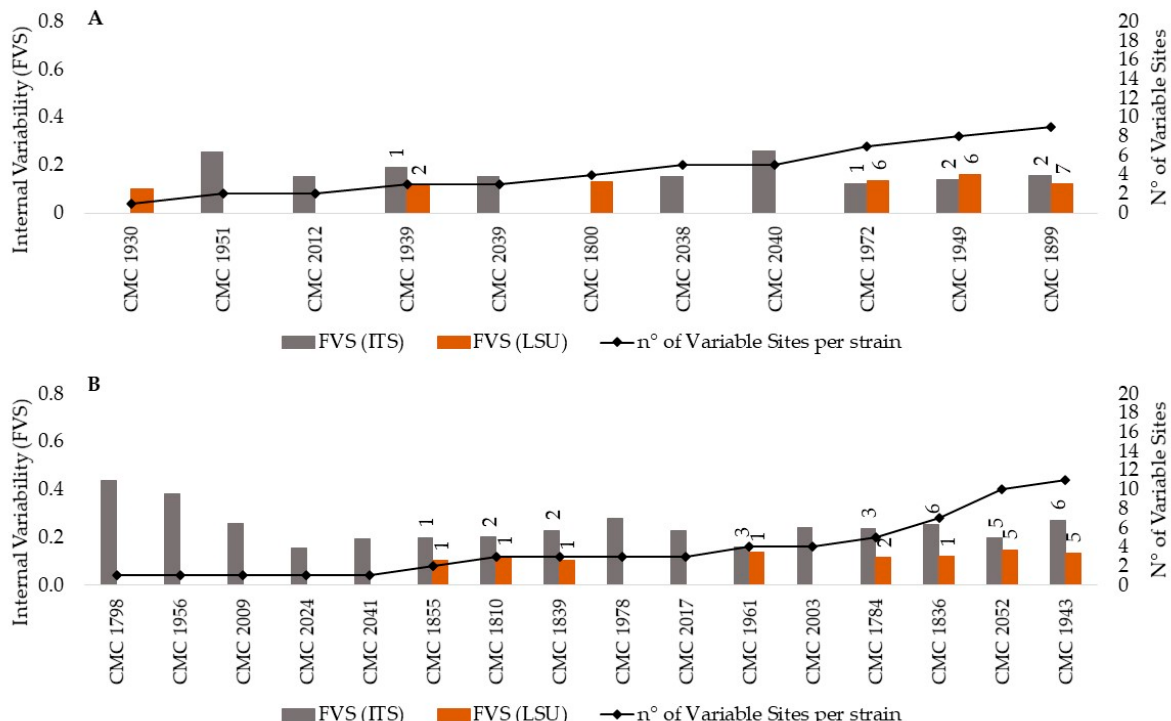
Figure 3. Heterogeneity of the rDNA within C. parapsilosis and C. tropicalis strains. Legend. Heterogeneity of the rDNA within C. parapsilosis ( A ) and C. tropicalis ( B ) strains. Internal variability is reported on the primary y-axes as frequency of variants per site (FVS) into the ITS (grey columns) and the LSU D1-D2 (orange columns) sequences of each strain. For each strain, the number of sites with more than 10% variants is reported on the secondary y -axis as number of variable sites. For those strains exhibiting sites with variants in both the ITS and the LSU D1-D2 sequences, the label indicates the number of variable sites detected in each region.